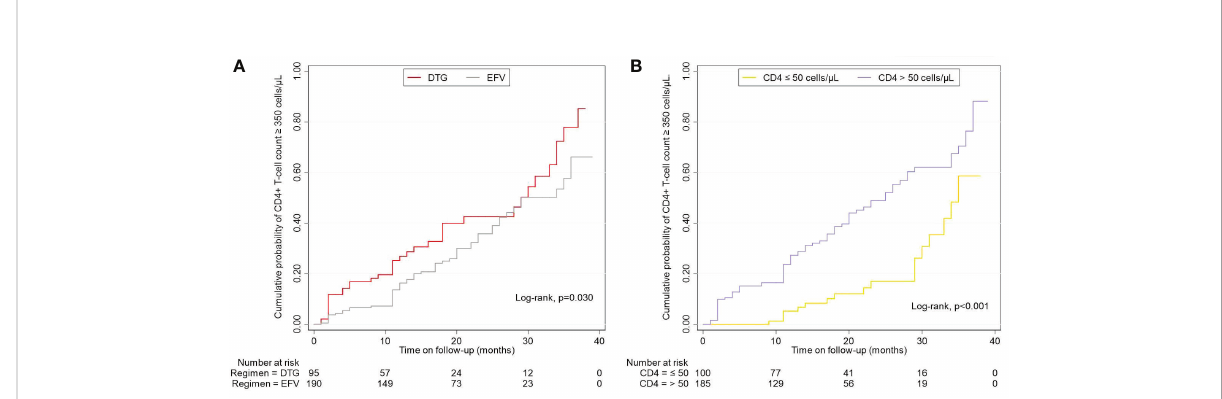
FIGURE 4 Effects of regimens and baseline CD4+ T-cell count on the cumulative probability of CD4+ T-cell count ≥ 350 cells/ m L. (A) Different regimens on CD4+ T-cell count ≥ 350 cells/ m L. (B) Baseline CD4+ T-cell count-strati fi ed results on CD4+ T-cell count ≥ 350 cells/ m L. EFV, efavirenz; DTG, dolutegravir.